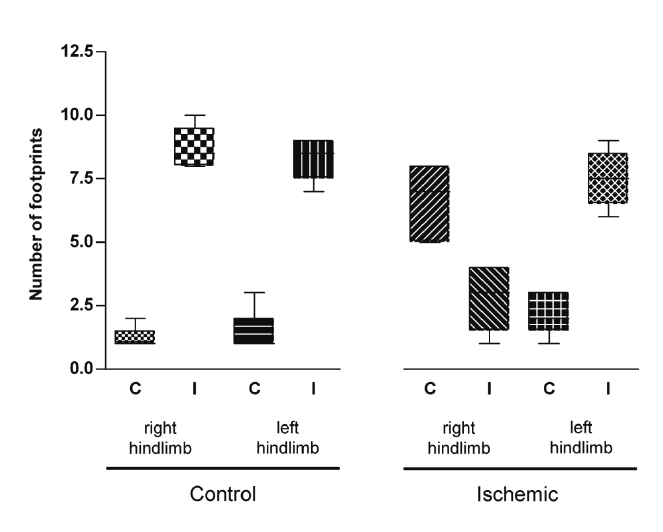
FIGURE 2 - Number of footprints after exercise in the treadmill of rats of Ischemic and Control groups. C- Complete footprints; I – Incomplete footprints. (—) mean; (□) confidence interval; (‡) standard deviation.